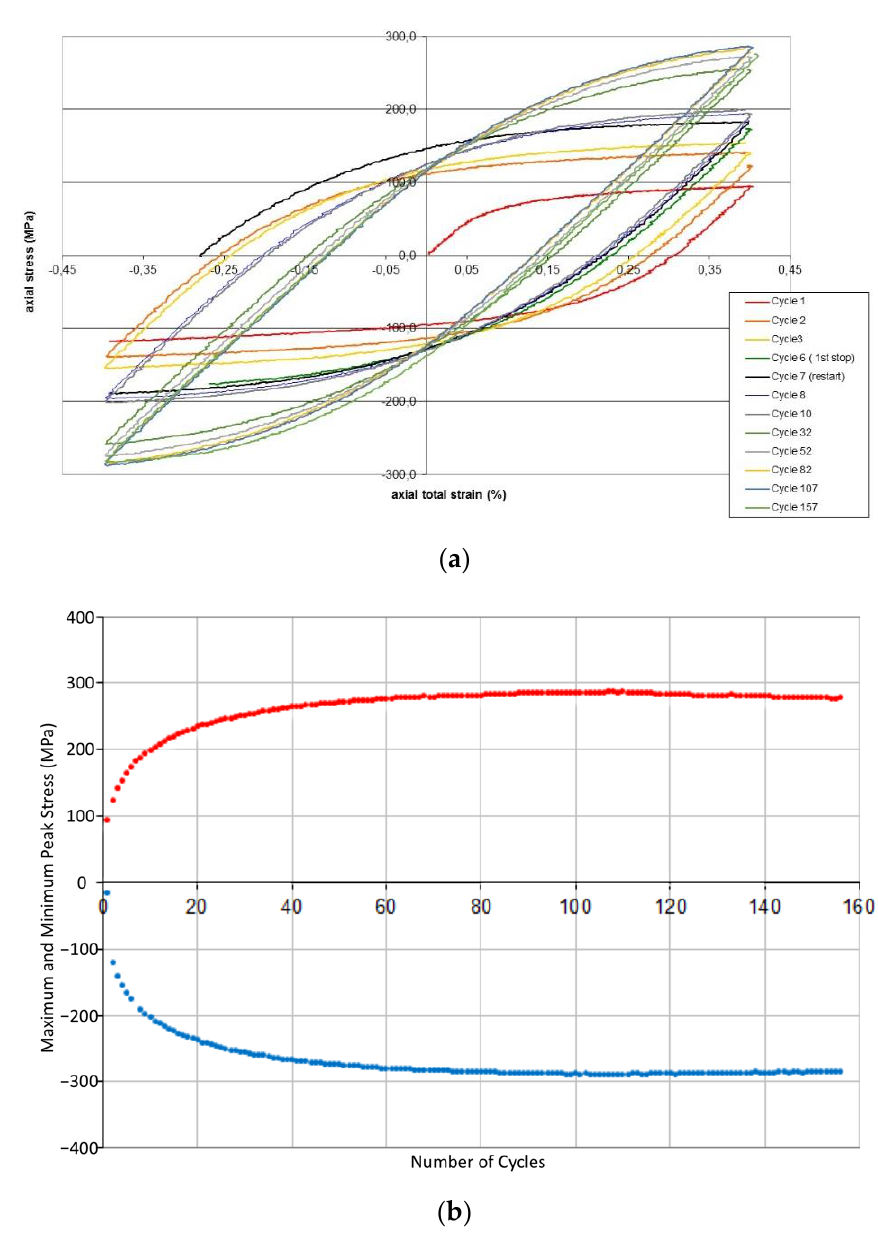
Figure 2. ( a ) The cyclic deformation of [001]-oriented copper single crystal at ambient temperature. Strains are plastic and elastic. ( b ) The evolution of the maximum and minimum peak stress with respect to the number of cycles.